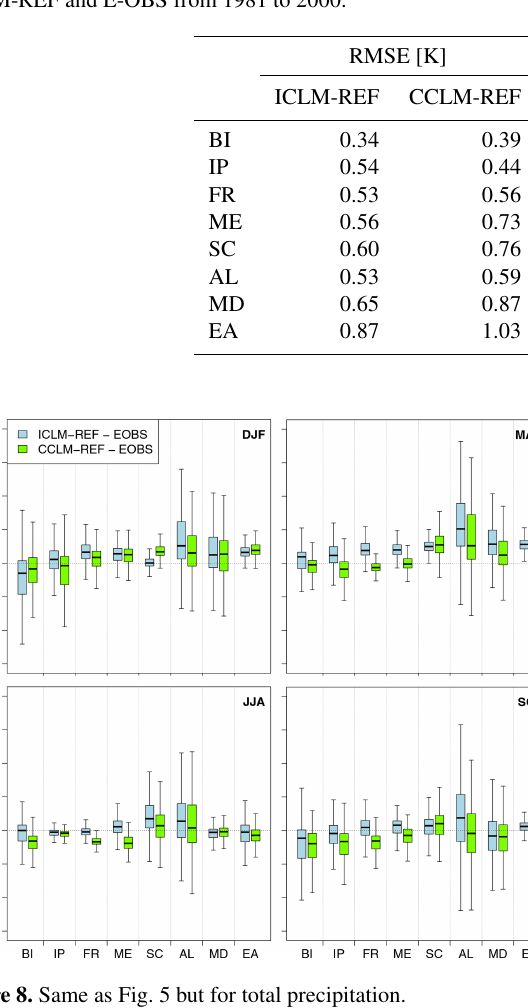
Figure 8. Same as Fig. 5 but for total